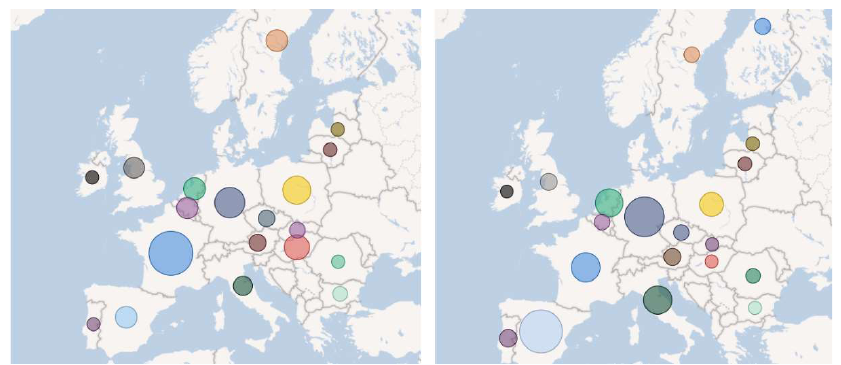
Figure 4. Qualitative representation of the production of CO ( left ) and RSM ( right ). Data for the studied valuable compounds per country as well as other substances of interest with high market potential (phenolic and sinapic acids for RSM and tocopherols and phytosterols for CO) can be found in Supplementary Materials where an interactive map for the different European countries has been included.